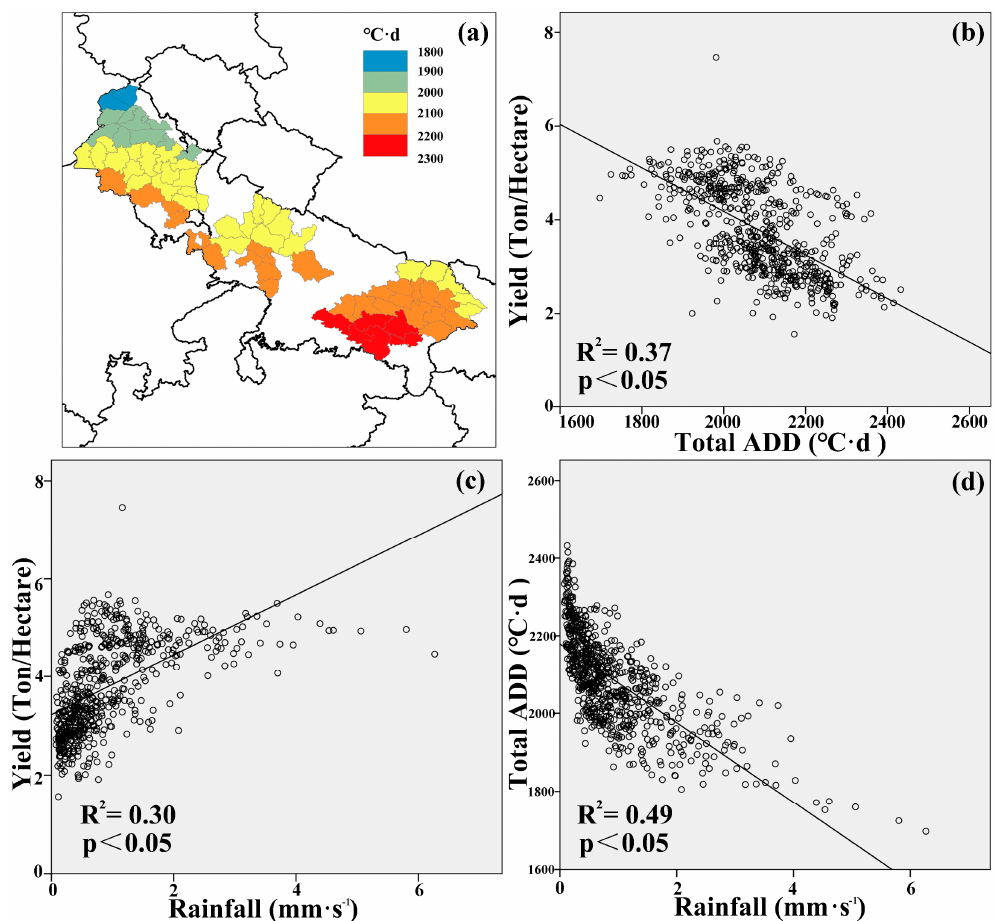
Figure 2. The spatial map of the total accumulated degree days (ADD) during the wheat grain-filling stage across the IGP ( a ), and the relationships between ( b ) the total ADD and yield, ( c ) rainfall and yield, and ( d ) rainfall and the total ADD at the district scale.